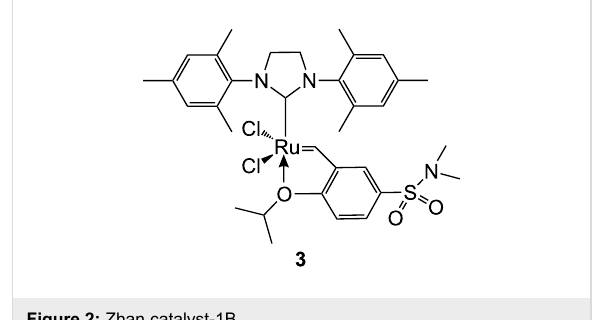
Figure 2: Zhan catalyst-1B.